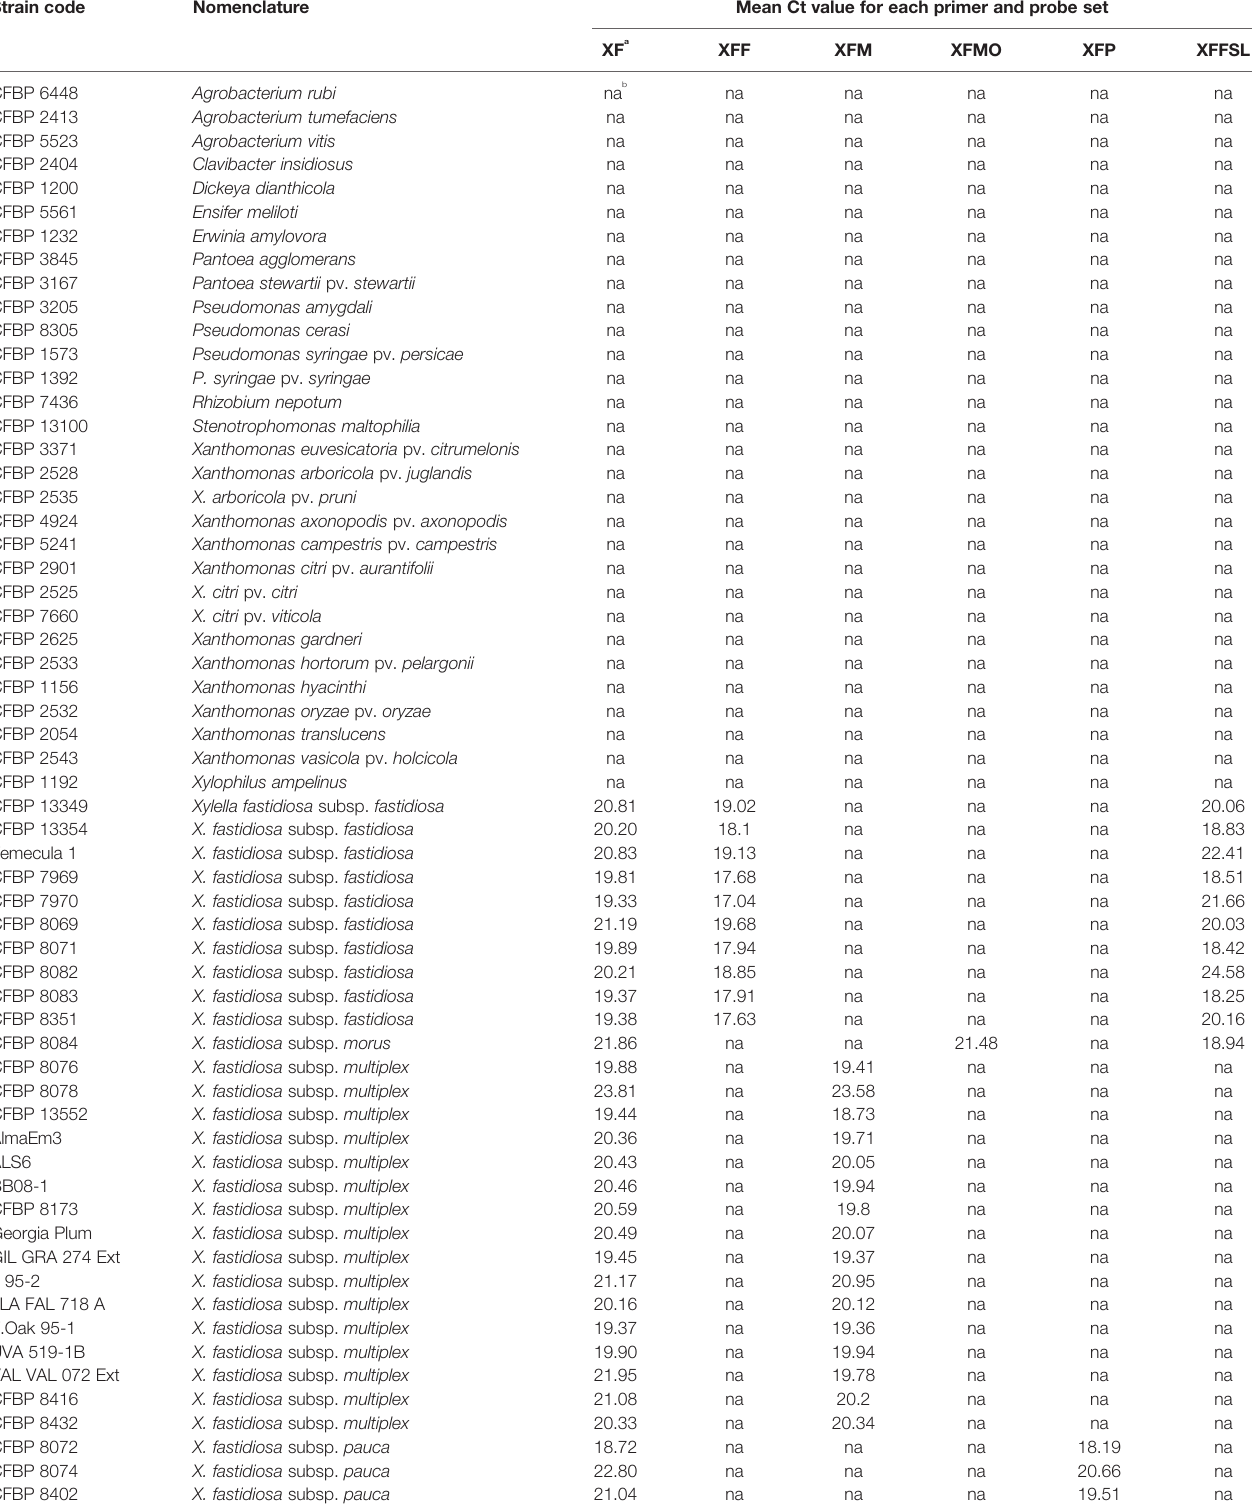
TABLE 1 | List of strains used in this study and signals obtained with the primers and probe combinations in simplex quantitative PCR (qPCR) assays on DNA suspensions calibrated at OD 600nm =